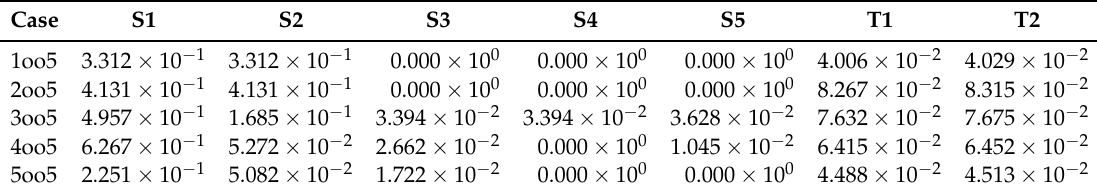
Table 5. Evaluation results using Birnbaum